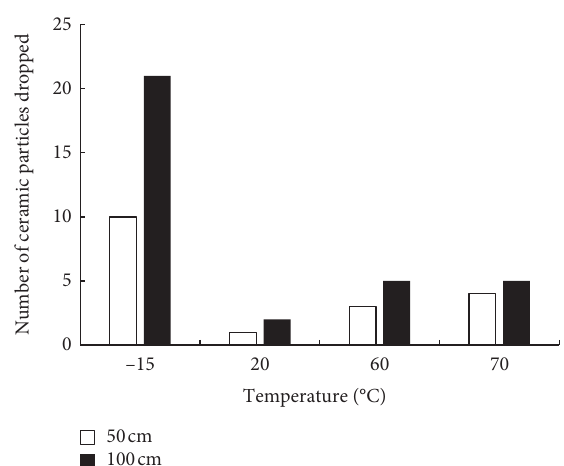
Figure 15: The adhesion of epoxy resin adhesive and ceramic